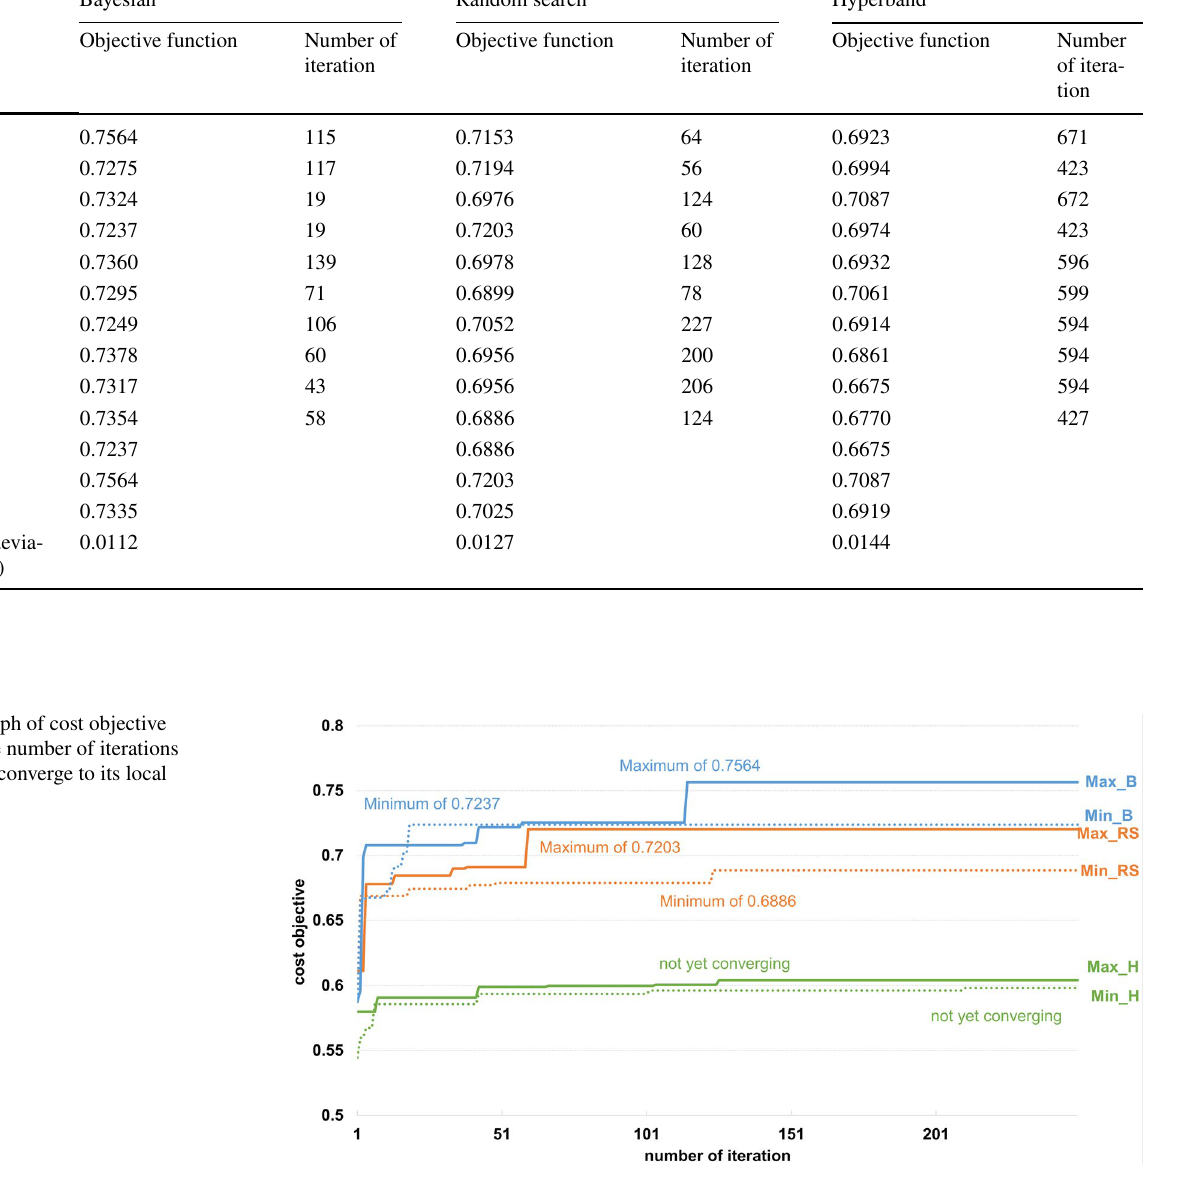
Table 2 Cost function of the ten independent runs of each HPO strategy, including the number of iterations to convergence Run